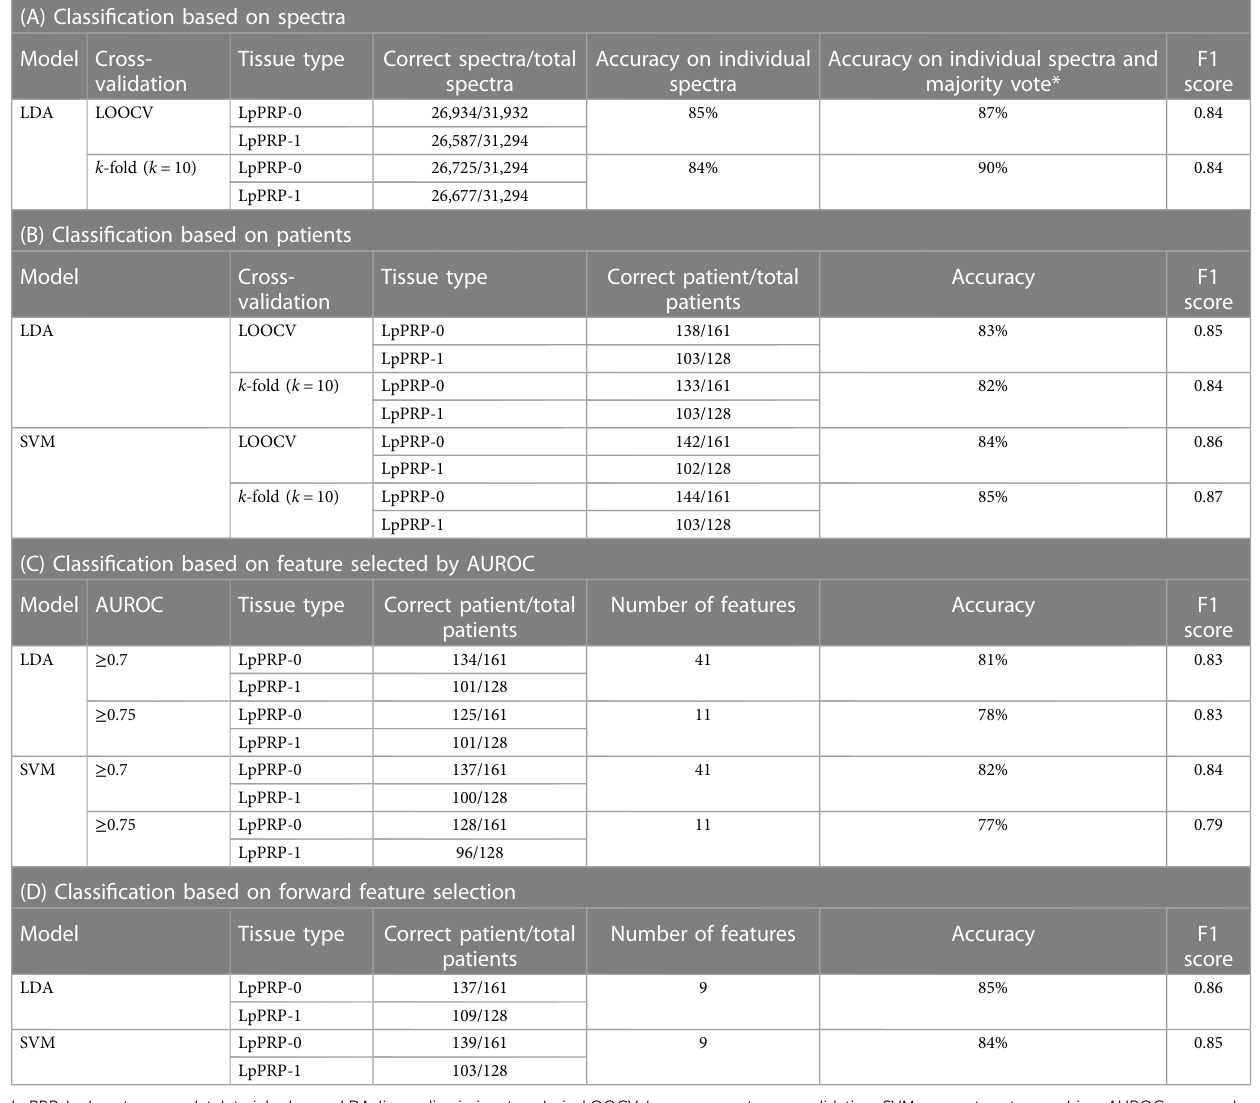
TABLE 1 Classi fi cation approaches to discriminate LpPRP-treated and -untreated patients. (A) Classi fi cation based on